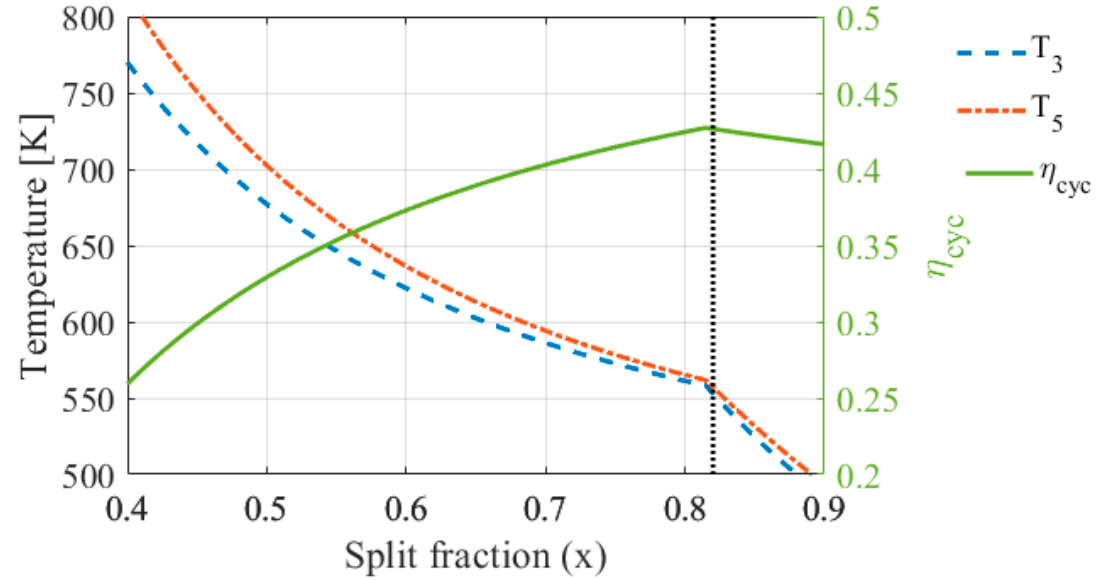
Figure 5. Variations in the values of T 3 , T 5 , and cycle efficiency with the split mass fraction.